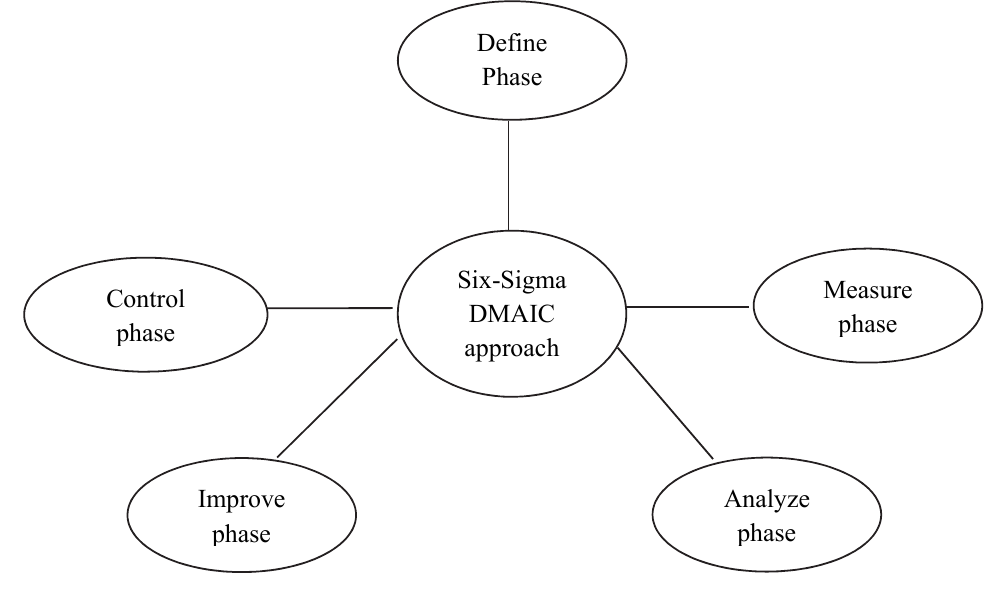
Fig. 1. Phases of Six-Sigma DMAIC